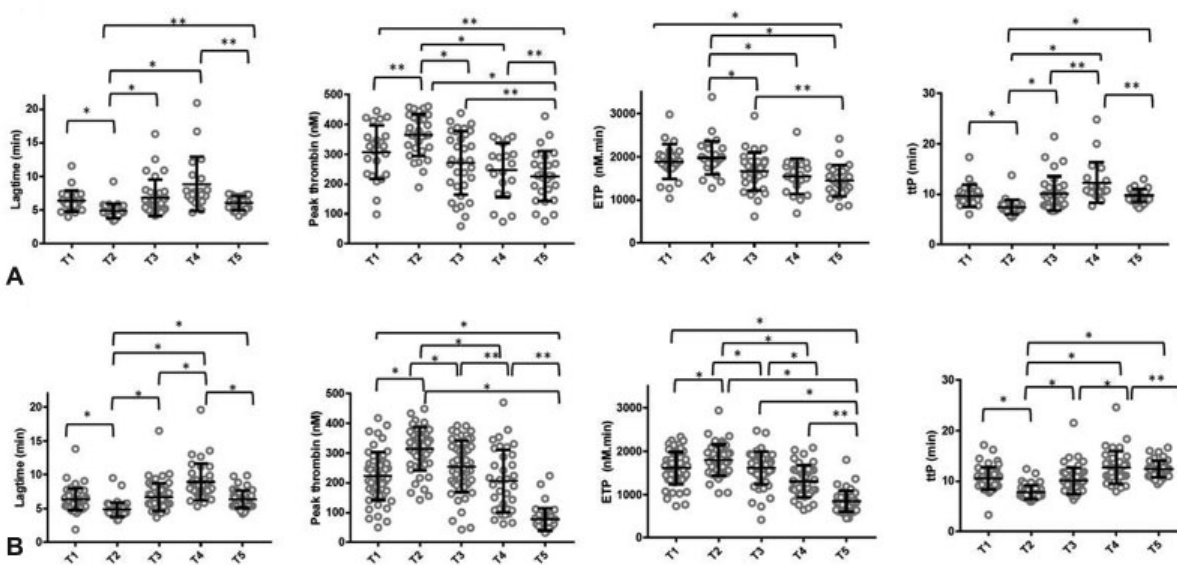
Fig. 3 Thrombin generation parameters in women before (T1) and after vaginal delivery ( A ) or caesarean section ( B ) (T2), following enoxaparin (T3), at 1 week postpartum (T4) and 6 weekspostpartum (T5). (cid:6) p < 0.001, (cid:6)(cid:6) p > 0.001 and < 0.05. Followinga Bonferroni correction, signi fi cance was assumed at α <